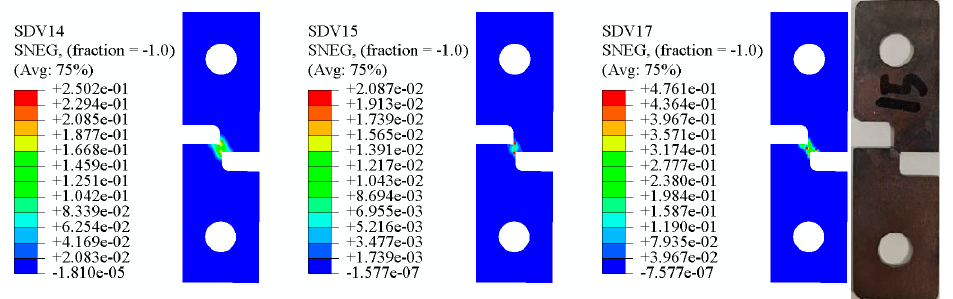
Figure 12. Equivalent plastic strain, VVF, shear damage at the beginning of microcrack in 0° speci- men, and the result diagram of the specimen.